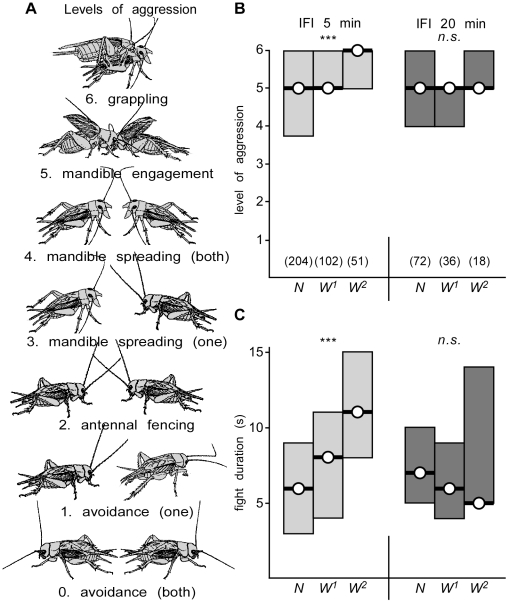
Stereotyped fighting and the winner effect in crickets.A Pictograms illustrating the escalating levels of aggression that characterize cricket fights (adopted from [15]): Level 0 mutual avoidance: non-aggressive interaction. Level 1 pre-established dominance: one cricket attacks, the other retreats. This level is in accordance with the avoiding behaviour of losers. Level 2 antennal fencing: the two crickets fence with their antennae. Level 3 mandible spreading (unilateral): one cricket displays broadly spread mandibles. Level 4 mandible spreading (bilateral): both crickets display their spread mandibles. Level 5 mandible engagement: the mandibles of both contestants interlock. Level 6 grappling: all-out fighting involving repetitive biting, mandible pushing, and opponent flipping. B, C Bar graphs giving the level and respectively duration of aggression for encounters between pairs of male, weight matched, fight-inexperienced crickets (naive, N), winners of one previous encounter (W1), winners of two previous encounters (W2) for inter-fight intervals (IFI) of 5 min (left side, grey bars) and 20 min (right side, dark bars). Numbers in parenthesis in (B) give the number of contests for each round, circles with bar the median, boxes the interquartile range and asterisks significant differences between all rounds in the tournament (Kruskal-Wallis one way variance test, *** p<0.001, n.s. not significant).